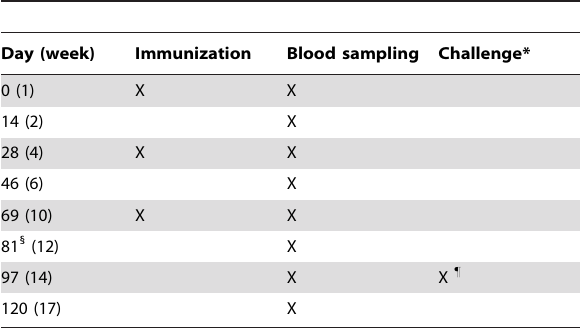
Table 2. Schedule of immunization, blood sampling and parasite challenge of Aotus lemurinus griseimembra .